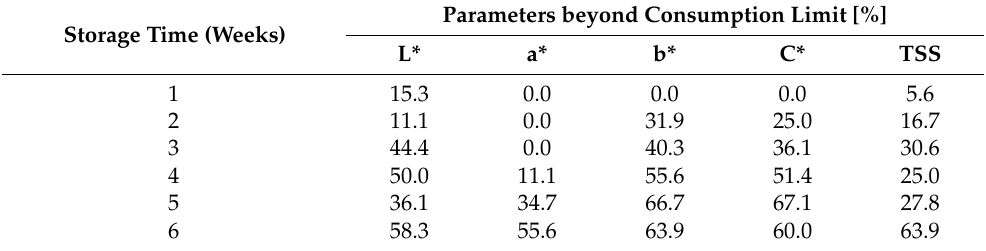
Table 3. The proportion of fruit specimens beyond the consumption limit in the case of color coordinates and TSS.